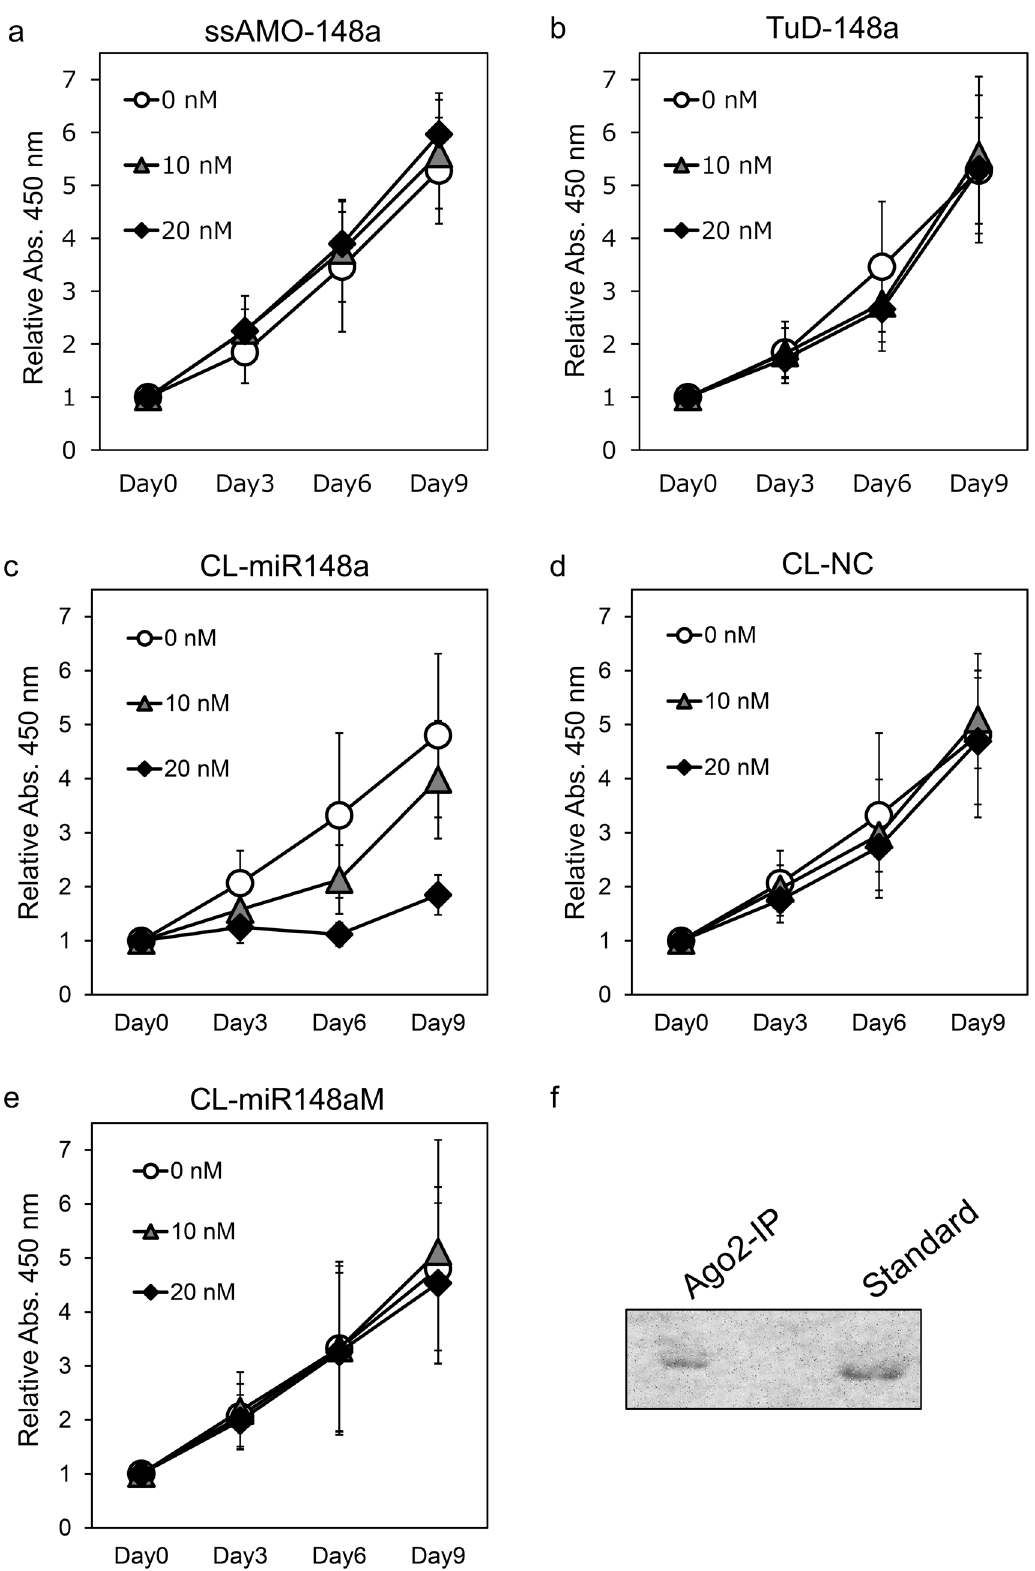
Figure 2. Analysis of cell proliferation after transfection with AMOs. ( a – e ) Plots of relative numbers of cells versus days after transfection with ( a ) ssAMO-148a, ( b ) TuD-148a, ( c ) CL-miR148a, ( d ) CL-NC, and ( e ) CL-miR148aM at a concentration of 0 (open circles), 10 (gray solid triangles), or 20 nM (black solid diamonds). Error bars represent SD. ( f ) Northern blot analysis of CL-miR148a coimmunoprecipitated with Ago2 (Ago2-IP) after transfection. “Standard” indicates CL-miR148a used for transfection. The uncropped image is shown in Supplementary Fig.